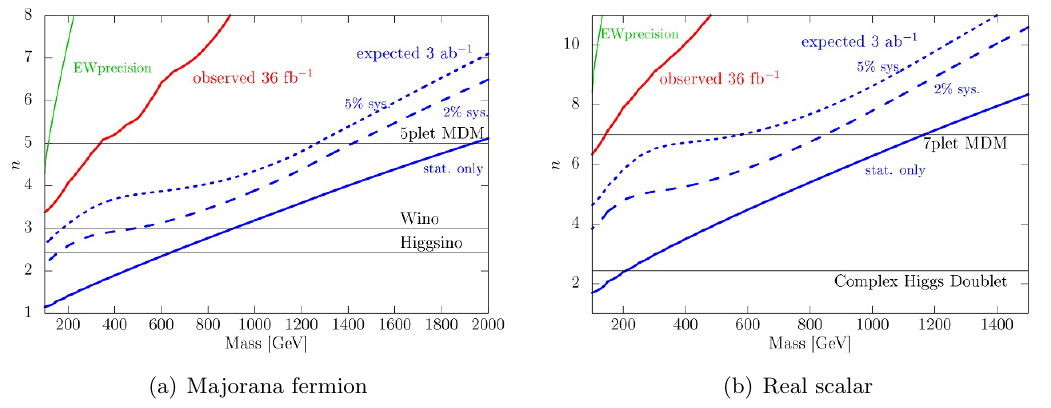
Figure 5 . The current limit and future prospect at 95% CL for the EWIMP are shown. The current limit is obtained by using the data at the 13 TeV LHC with the integrated luminosity 36 fb (cid:0) 1 and the future prospect by 14 TeV and 3 ab (cid:0) 1 LHC. The region above each line can be experimentally excluded. The n in the vertical axis shows the e(cid:11)ective number of SU(2) L gauge charge. at 95% CL. For the cases of a Dirac fermion and complex scalar with SU(2) L quantum number n , we can estimate corresponding n corr by solving n corr : ( n 2 1) = 2 n ( n 2 1), corr : (cid:0) (cid:0) as the overall factor comes from eq. (2.3). For the future prospect, we adopt same binning as the current ATLAS study and assume the systematic uncertainty 5%, 2% and 0% for each bin. The corresponding sensitivity curves are shown in blue dotted, dashed and solid lines in the (cid:12)gure, respectively. We also show the current constraint from the electroweak precision measurement at the LEP in the green lines [51]. In the (cid:12)gure, we show the quantum number of several benchmark particles in the horizontal lines. Note that the SU(2) L quantum numbers of the Higgsino and complex Higgs doublet are estimated to be n corr 2 : 43, as they are not a Majorana fermion or real scalar. ’